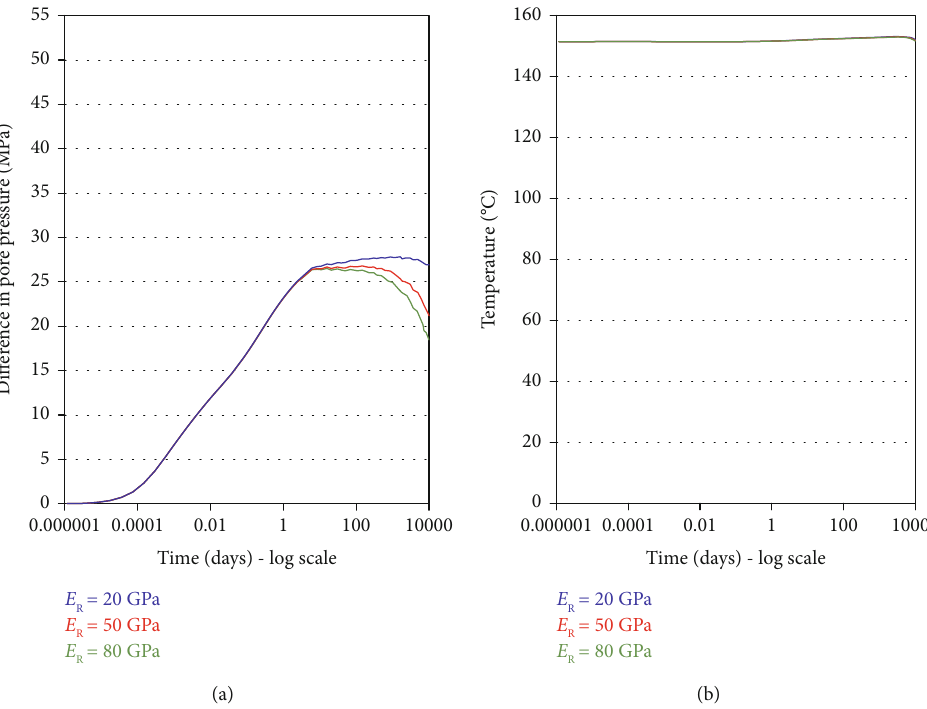
fi ning intact rock on the time evolution of the di ff erence in the fl uid pore pressure Figure 14: E ff ect of the elastic modulus E R of the con between the injection and production boreholes (a) and the temperature at the production borehole